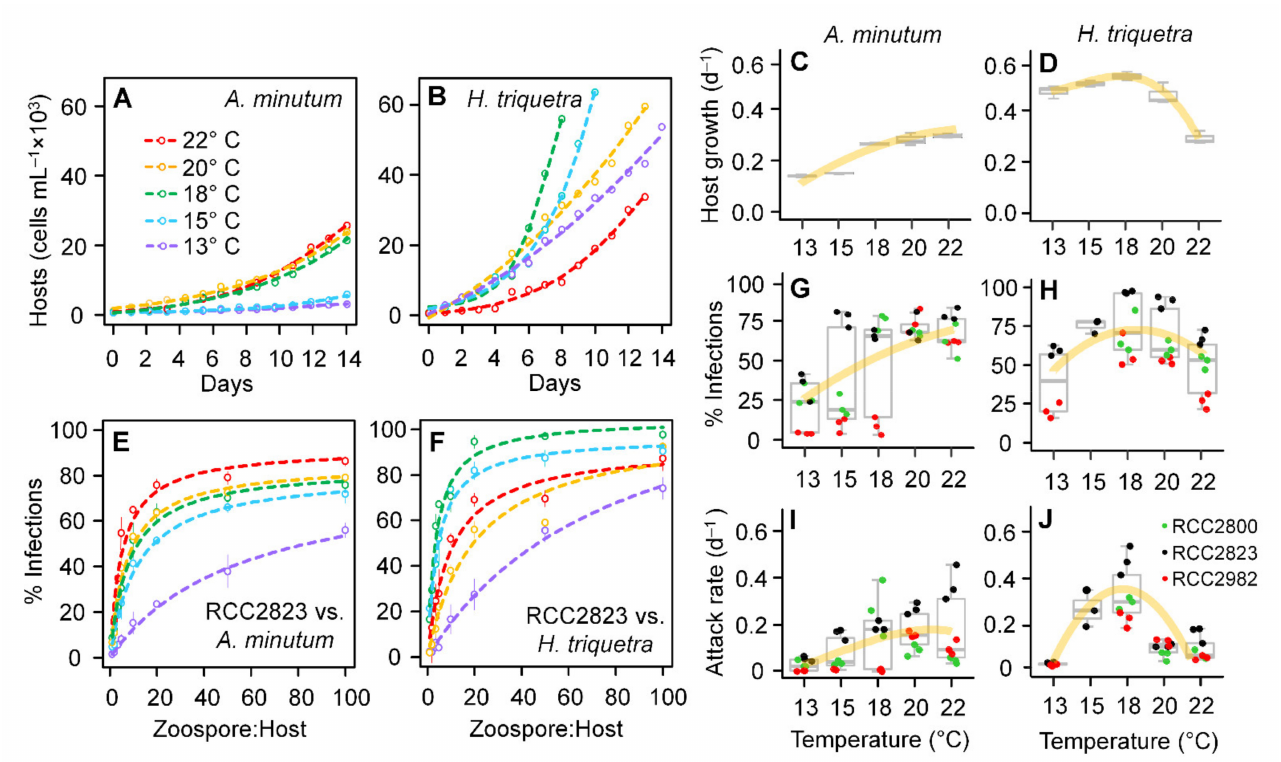
Figure 4. Effect of temperature on cell density ( A , B ) and growth rates ( C , D ) of the dinoflagellate hosts Alexandrium minutum ( A , C ) and Heterocapsa triquetra ( B , D ) in the absence of parasitoids; effect of temperature on the functional response of Parvilucifera rostrata RCC2823 on both A. minutum ( E ) and H. triquetra ( F ) (functional responses of P. rostrata RCC2800 and RCC2982 on both hosts are shown in Figure S2); infection rates ( G , H ) and attack rates ( I , J ) for the three Parvilucifera strains infecting the two